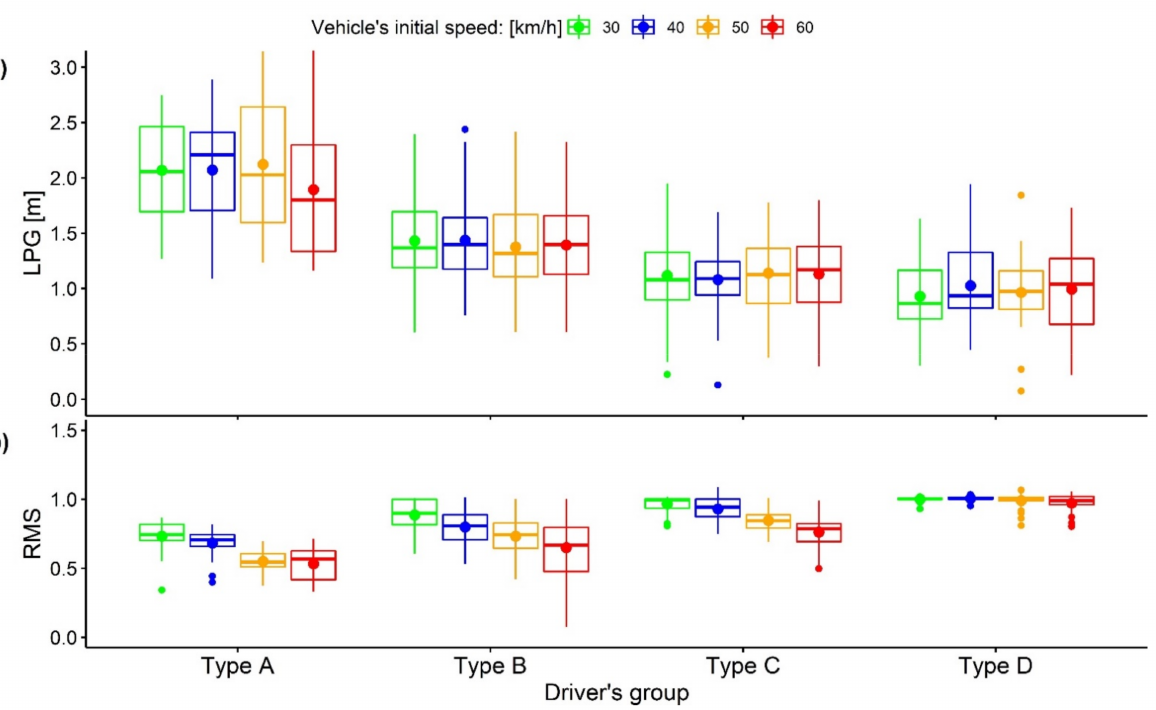
Figure 6. Box plots of the minimum lateral gap while passing VRU ( a ) and the ratio of SV’s minimum velocity to initial speed while approaching VRU ( b ), grouped by initial speed between driver’s